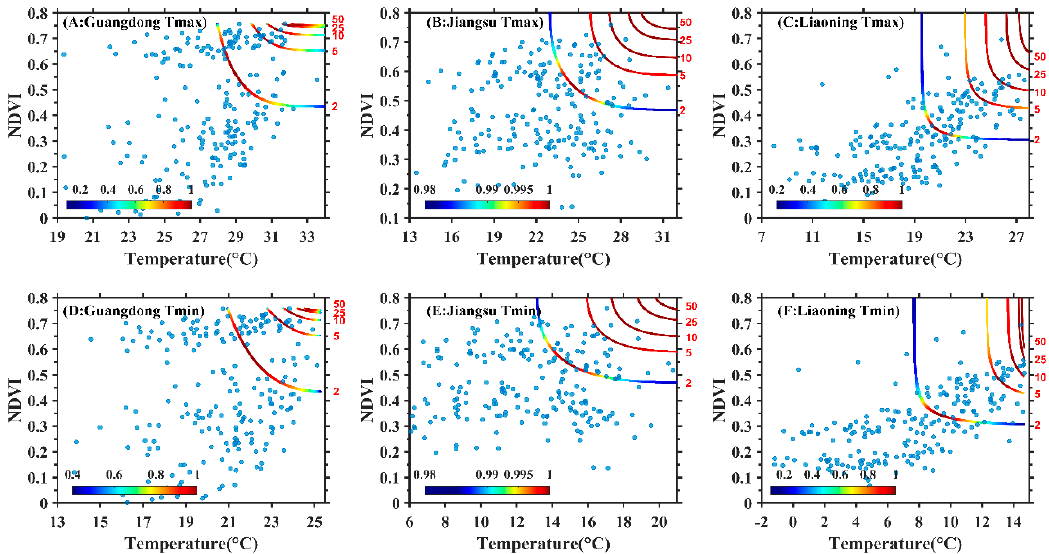
Figure 5. Copula joint return periods of Tmax–NDVI and Tmin–NDVI in spring in Guangdong, Jiangsu and Liaoning from 1982 to 2016.